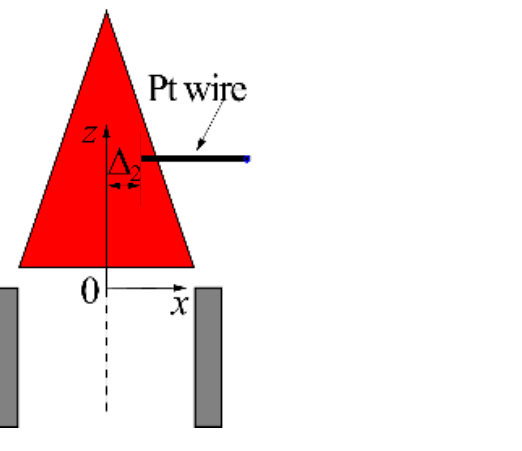
Figure 6. Schematic of the electrode structure for the experiments of Factor 3. Table 5. Experimental conditions for Factor 3.